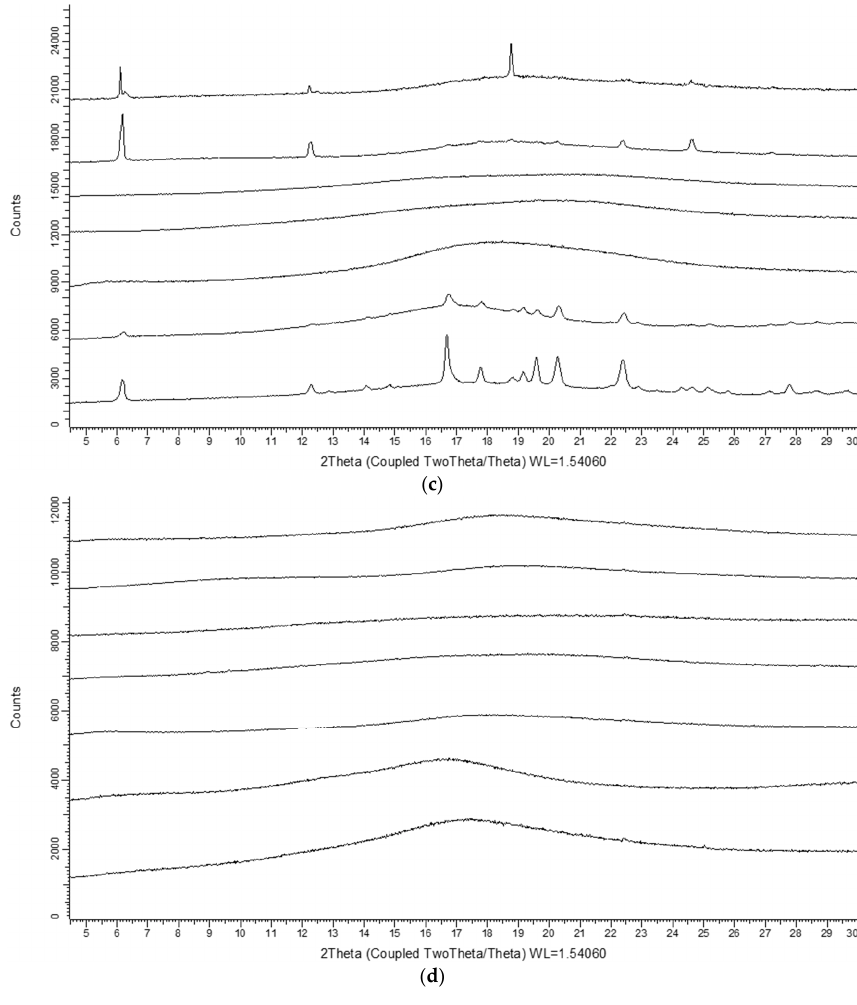
Figure 7. ( a , b ) Reverse heat flow signals and ( c , d ) X-ray powder diffraction (XRPD) patterns of ASDs of IBU 40:60 ( w / w ) with HP50, HAS, PVA, PK30, SOL, EUD, and EUD55 (from top to bottom ) produced by film casting performed: ( a , c ) at RT and ( b , d ) under reduced